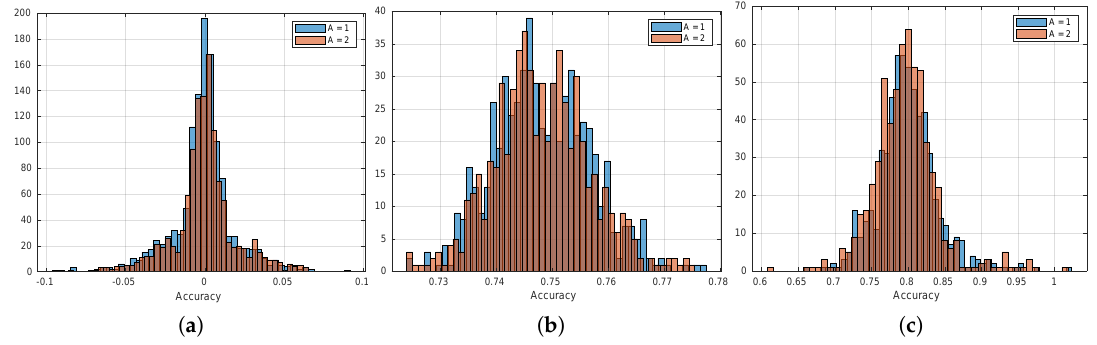
Figure A6. Histograms for the conclusions about the effect of factor A on the expected accuracy performance, represented for the two levels of such factor with additional restrictions on the population. ( a ) Factor C = 1. ( b ) Factor B = 1 and factor C = 2. ( c ) Factor B = 2 and factor C = 2.